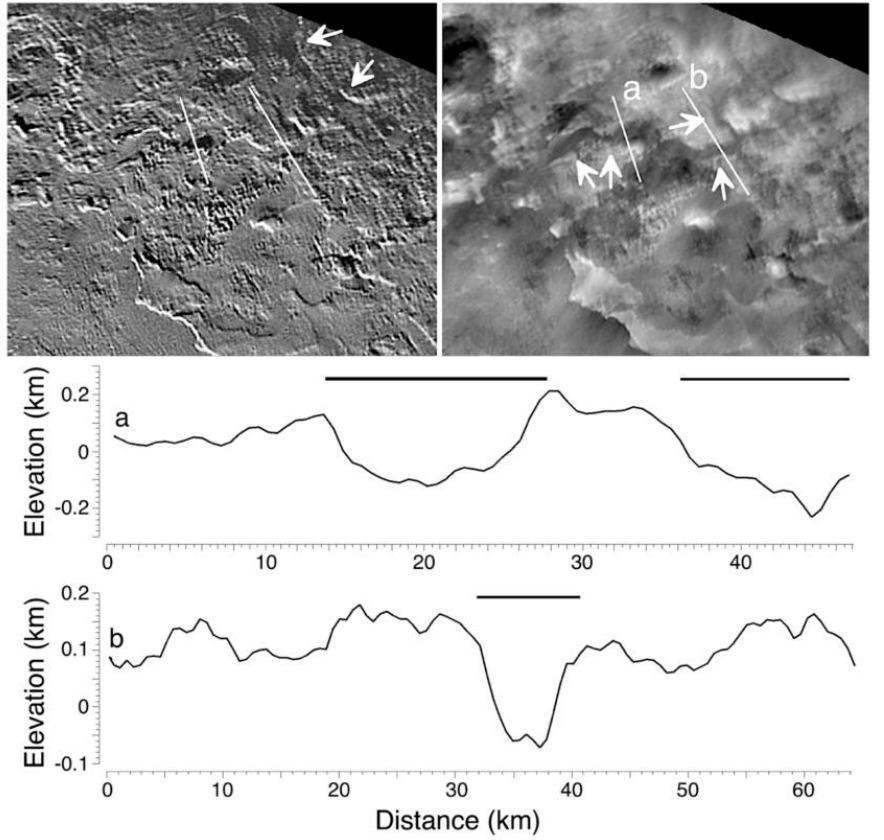
Figure 15. Topographic profiles across sinuous channel-like depressions north of Ruach Planitia. Note also shallow walled plains south of indicated channels. ( top ) Image mosaic and ( right ) DEM scene widths are ~150 km from SG-PC-DEM in Figure 8. Note different horizontal scales in profiles. Horizontal bars indicate extent of relevant